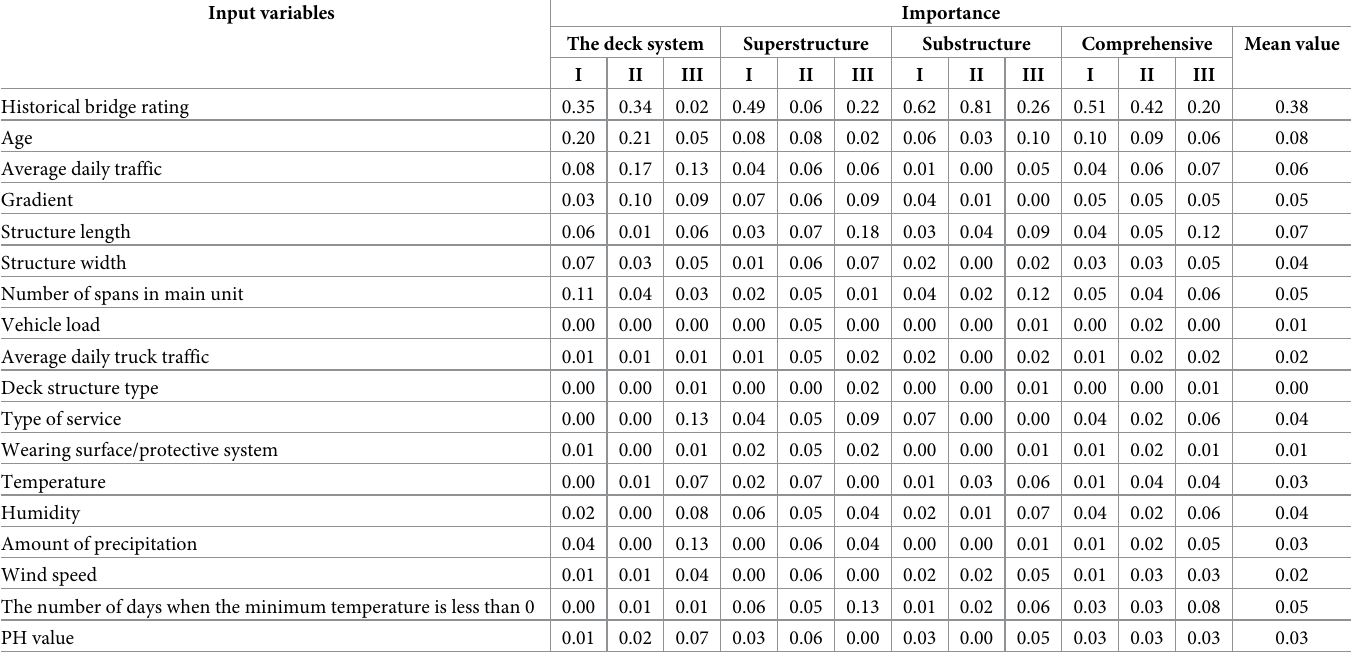
Table 6. Importance of input variables in DT model of concrete beam